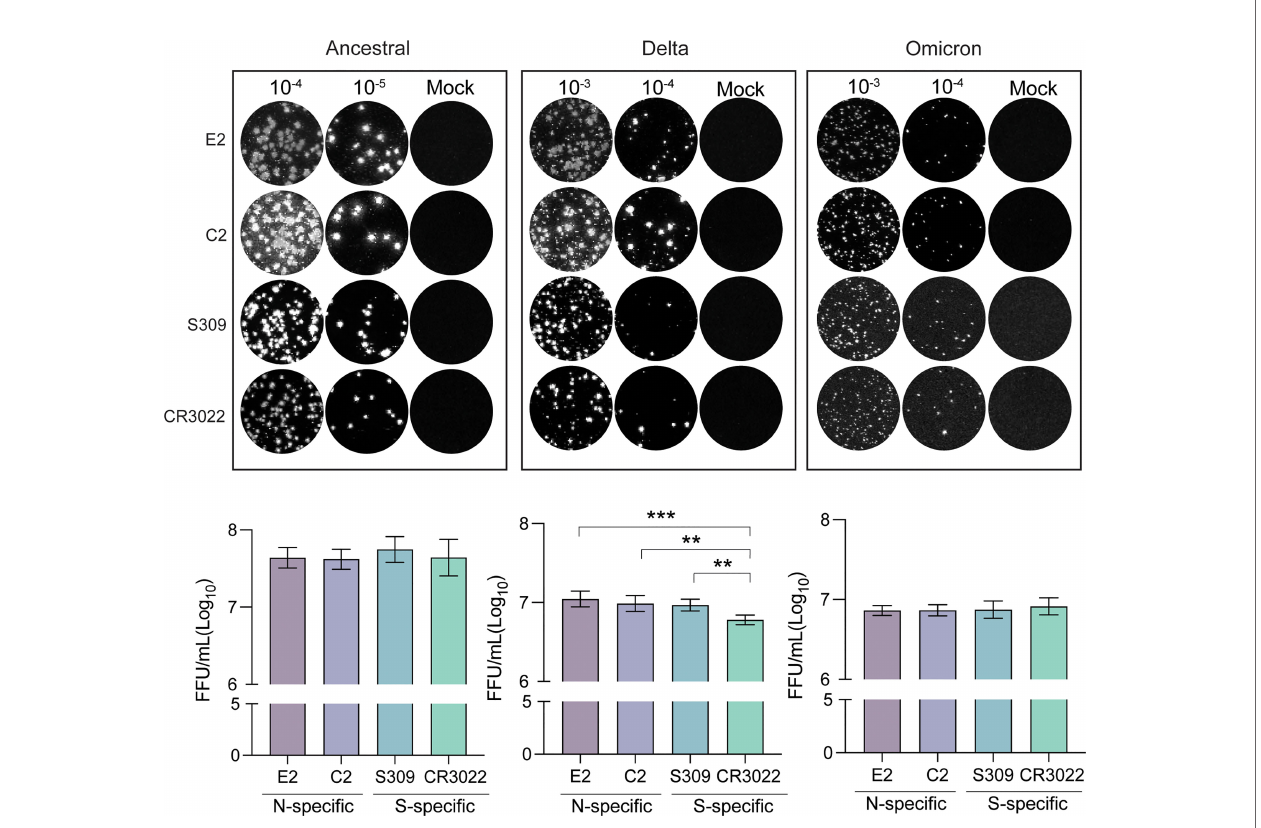
FIGURE 4 | Immunoplaque assays using N-speci fi c immunostaining. Representative dilutions for each variant and staining method are shown. Titers for each variant are shown below calculated from analyses in triplicate. Statistical analysis was conducted using an ordinary one-way ANOVA with Tukey ’ s test where ***, p < 0.0005 & **, p <